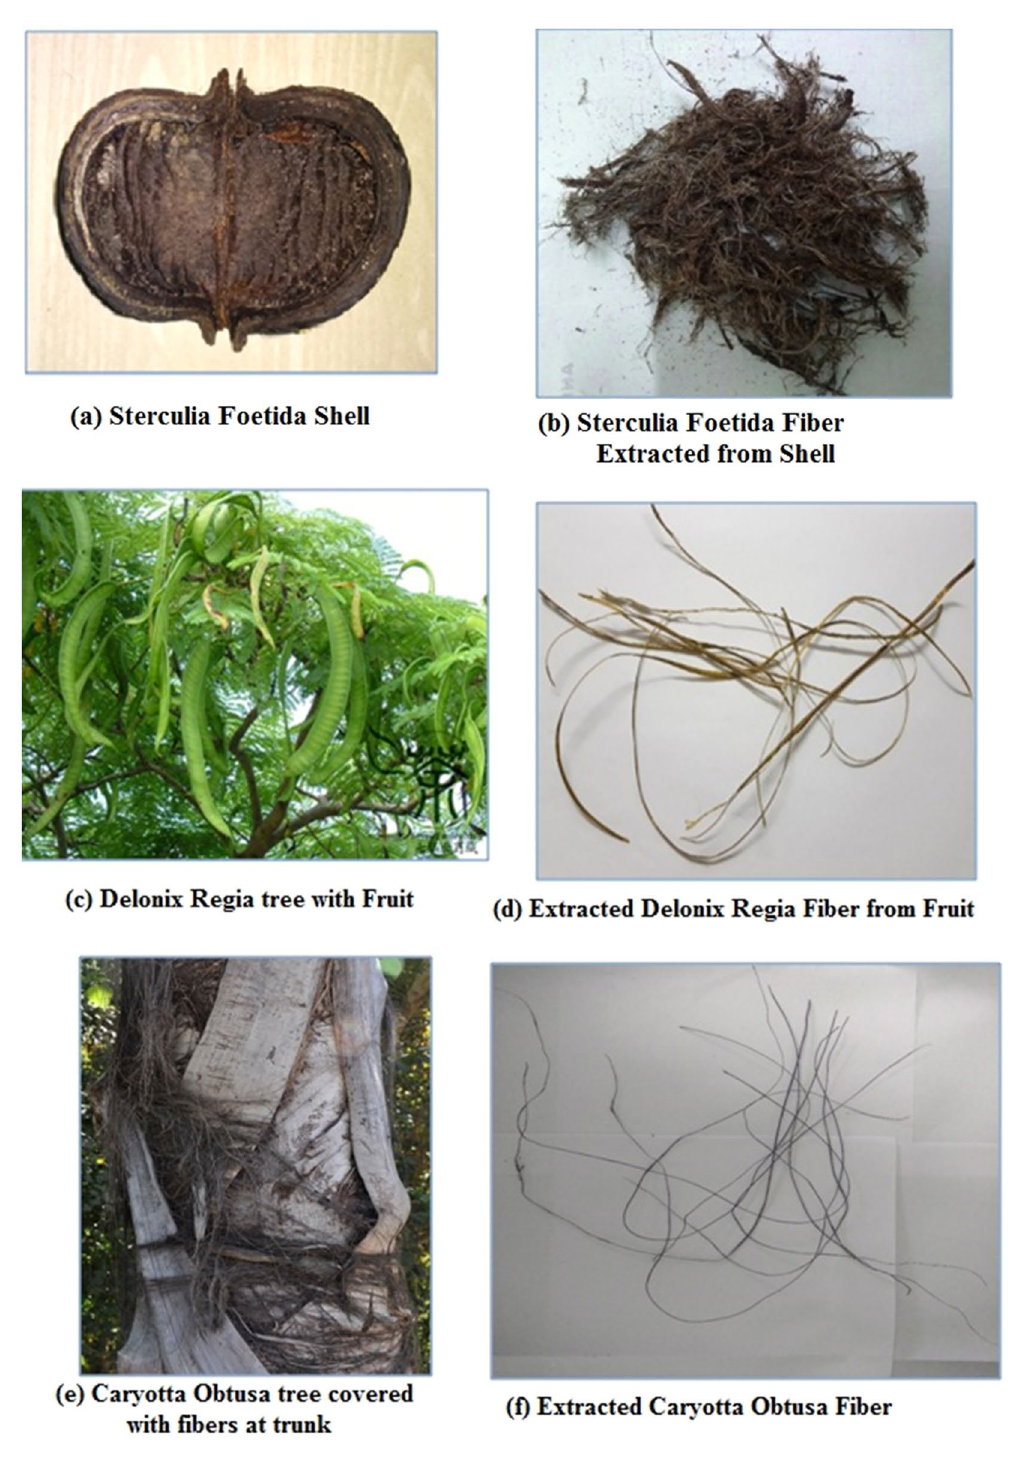
Fig. 1 Extraction of natural